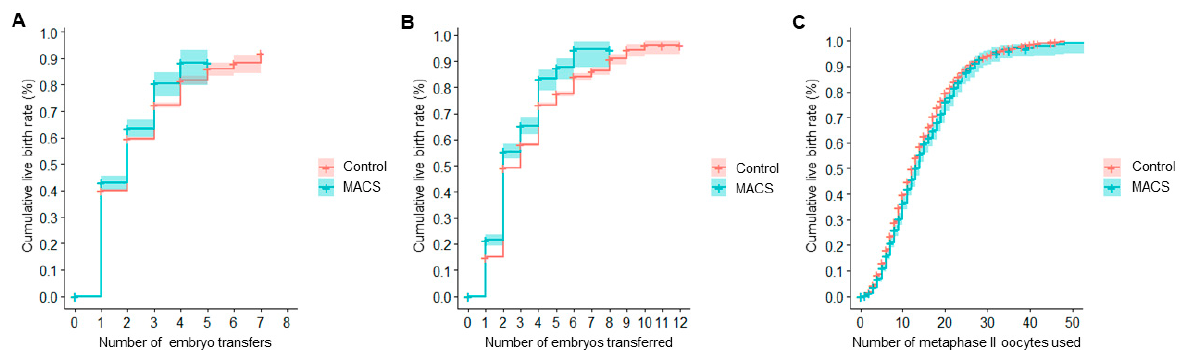
Figure 1. Cumulative live birth rates (CLBR) resulting from the unadjusted analysis of reproductive outcomes in cycles using autologous oocytes. A . CLBR per embryo transfer. B . CLBR per embryo replaced. C . CLBR per patient’s own metaphase II oocytes used.